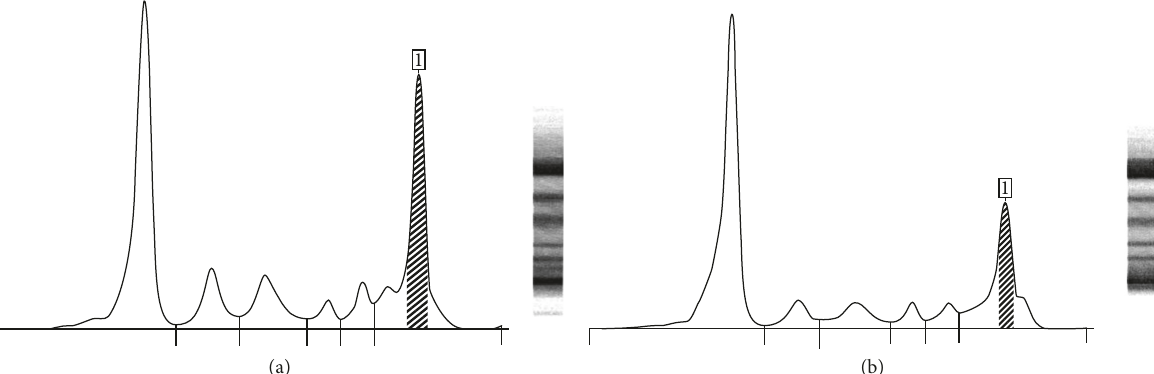
Figure 2: Serum protein electrophoresis before (a) and after (b) therapy. After therapy, there was a reduction of the monoclonal component (1).